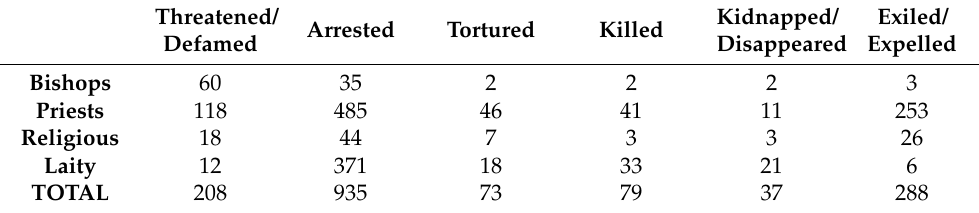
Table 1. Documented repression against the Catholic Church (1964–1978) 1